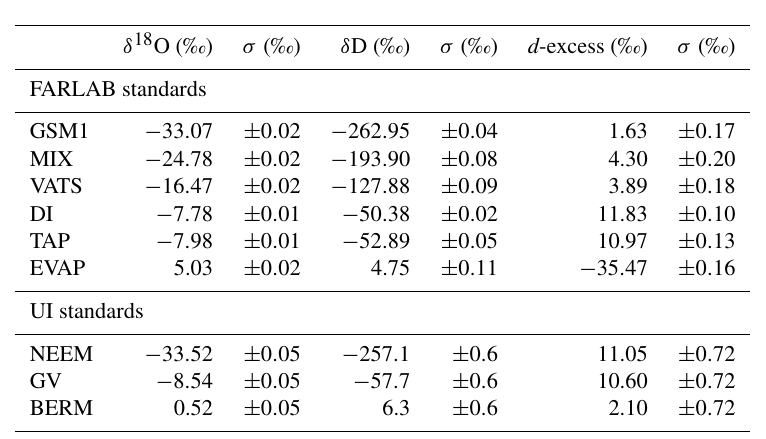
Table 2. Isotope compositions of the standard waters used in this study. The values are reported on the VSMOW2–SLAP2 scale. FARLAB standards are the laboratory standards used at FARLAB, University of Bergen, and UI standards are the laboratory standards used at the isotope laboratory of the University of Iceland. All the waters are at laboratory working standards, except MIX and TAP. MIX is obtained from an even mixing of GSM1 and VATS. TAP is deionised tap water from Bergen, Norway. The isotope compositions of these two waters are calibrated in experiment 9 by using the measured working standards. The σ for FARLAB standards represents the standard deviation of the mean for the six liquid injections, while σ for UI standards is a long-term standard deviation.